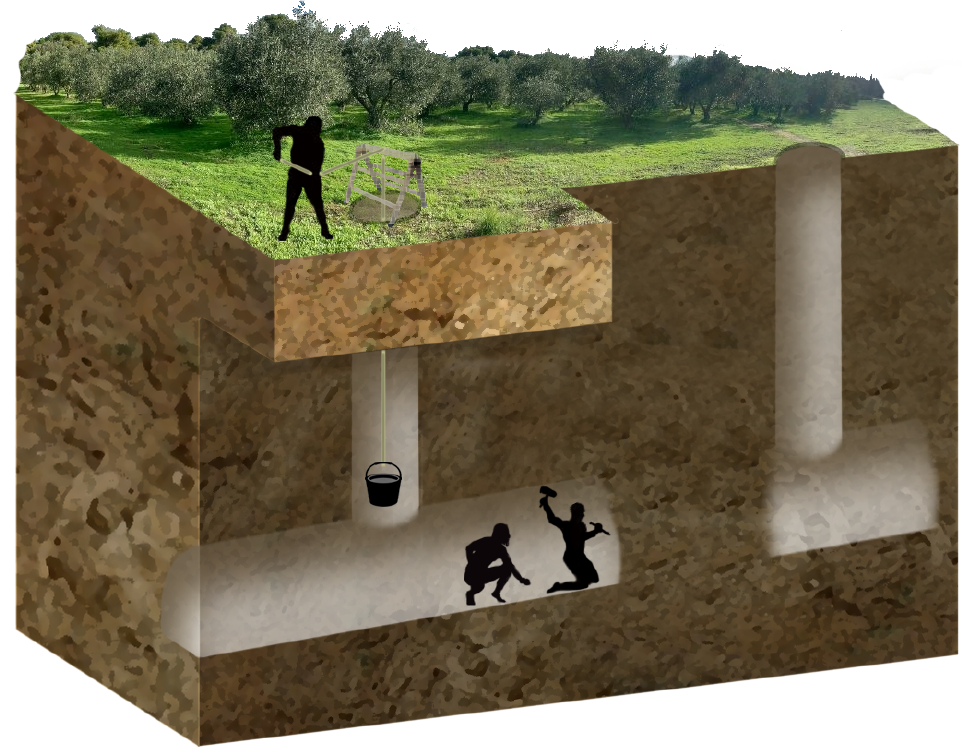
Figure 19. The continuous worker.